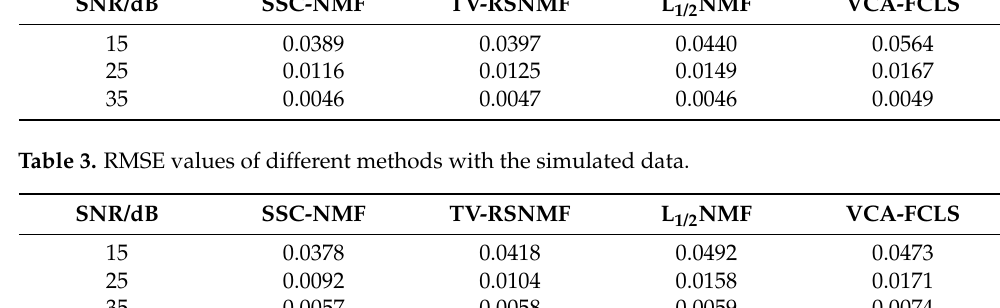
Table 2. SAD values of different methods with the simulated data. SNR/dB